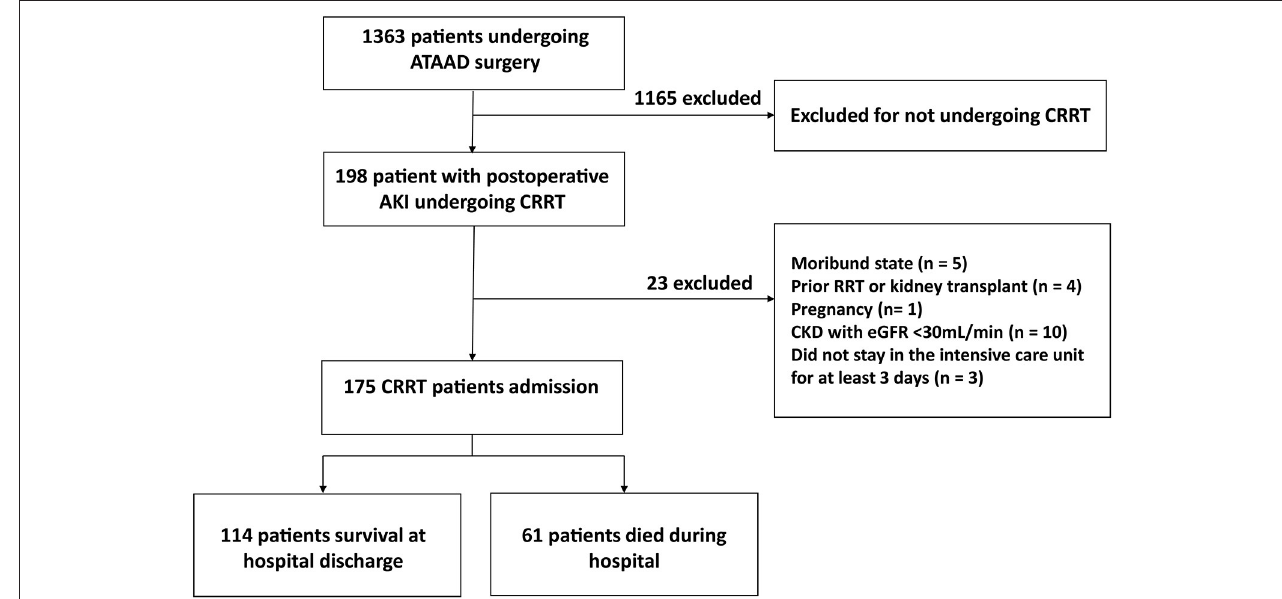
FIGURE 1 | Study flowchart. OR, Odds ratio; CI, confidence interval; PND, permanent neurological